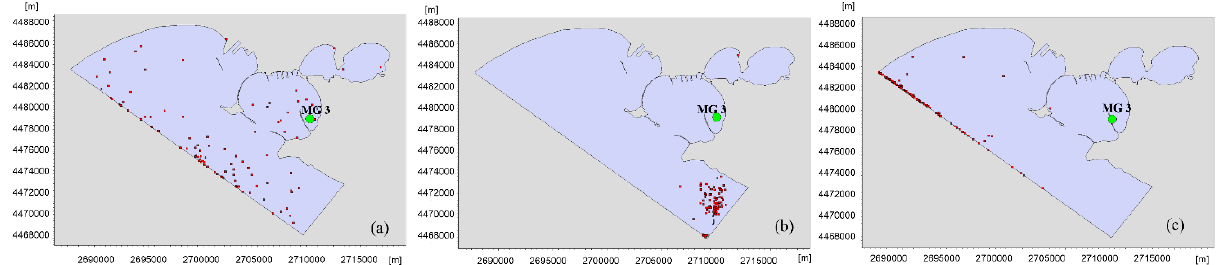
Figure 15. Percentage PT3 (MG3) — the cloud of particles: ( a ) 30 days after release; ( b ) 60 days after release; ( c ) 90 days after release at bottom layer.